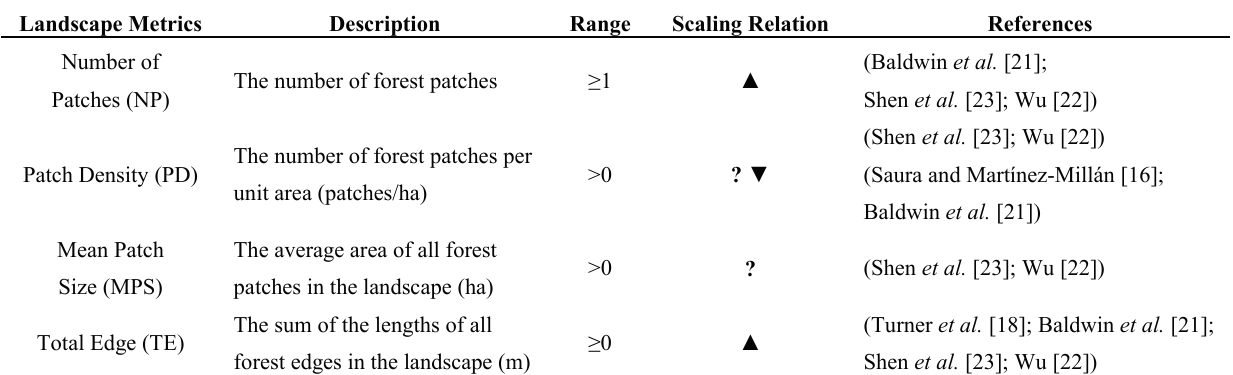
Table 1. List of pattern metrics used in the study. Landscape metrics and the relative acronyms, descriptions, variation ranges and scaling relations based on published references were provided. Symbols: ▲ increase, ▼ decrease, ? unpredictable, = no sensitivity, ▲▼ increase then decrease